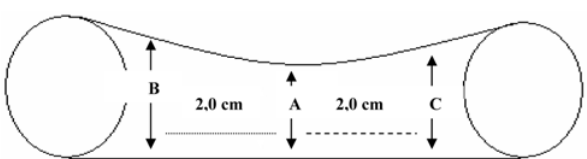
FIGURA 4: Esquema representando a maneira de obtenção das medidas duodenais